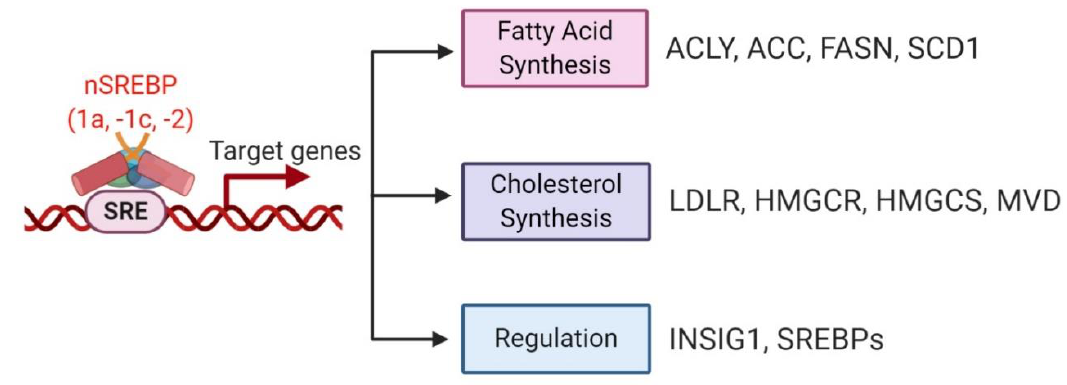
Figure 4. Downstream target genes of SREBPs. The homo- and heterodimerized nSREBPs (-1a, -1c and -2) enter the nucleus, in combination with other coactivators, bind to sterol regulatory elements (SREs) in the promoters / enhancers and activate transcription of target genes. SREBP-1a, -1c specifically activate genes involved in fatty acid synthesis, such as ACLY, ACC, FASN and SCD1. SREBP2 preferentially targets genes involved in cholesterol biosynthesis, such as LDLR, HMGCR, HMGCS , and MVD . INSIGs are negative regulators of SREBP proteolysis, while the INSIG1 gene itself is a target of the nSREBPs. Thus INSIG1 is also regulated by SREBPs. As a target gene of itself, SREBPs mRNA can be induced and regulated by nSREBPs as well. ACLY, ATP citrate lyase; ACC, acetyl-CoA carboxylase; FASN, fatty acid synthase; SCD1, stearoyl-CoA desaturase 1; HMGCS, HMG-CoA synthase; HMGCR, HMG-CoA reductase; LDLR, low density lipoprotein receptor; MVD, diphosphomevalonate decarboxylase; INSIG1, insulin-induced gene